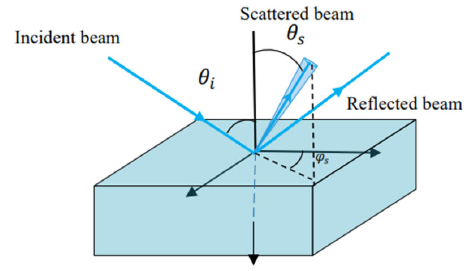
Figure 1. Scattering geometry for the definition of BRDF.